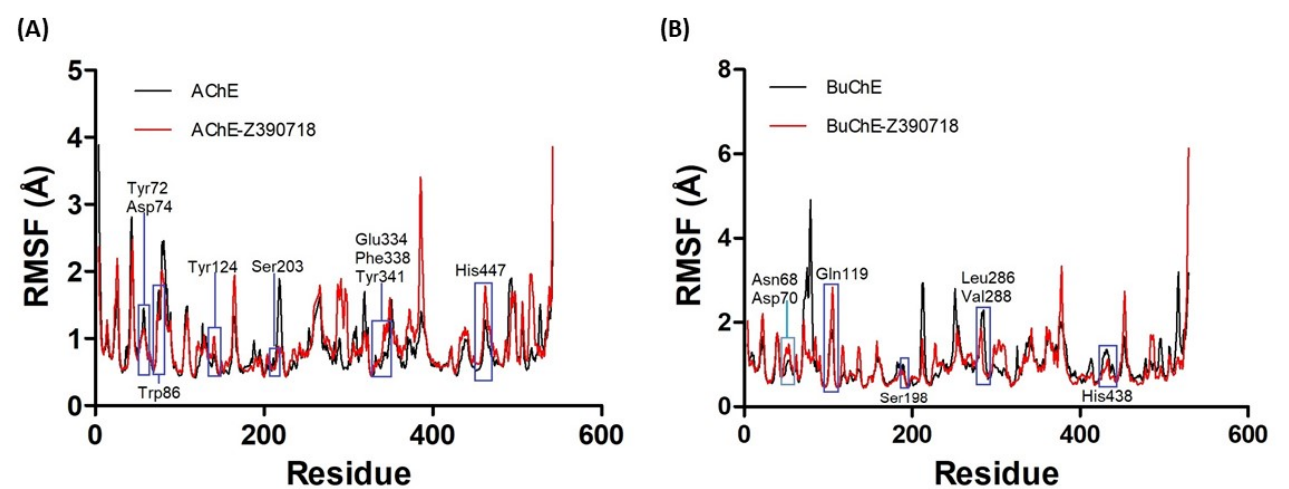
Figure 6. RMSF (Å) of backbone C α atoms of the APO structures and complexes of AChE ( A ) and BuChE ( B ) with ZINC390718 during the production phase (AChE apo: 15 to 100 ns; AChE complex: 15 to 50 ns) (BuChE apo: 20 to 95 ns; BuChE complex: 5 to 50 ns). Highlights in blue correspond to regions of the active site.